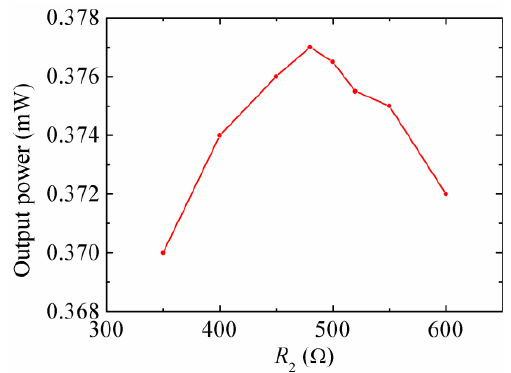
Figure 12. The output power of the stand-alone EMEH for different R 2 at the resonant frequency.